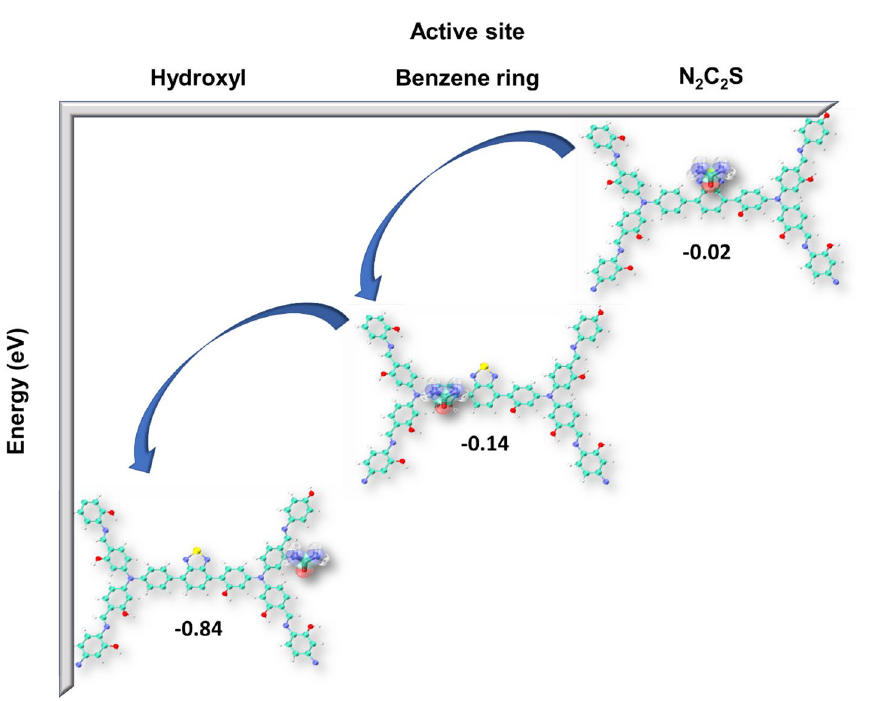
Figure 6. The adsorption energy of urea by TPA-COF-OH computed by DFT